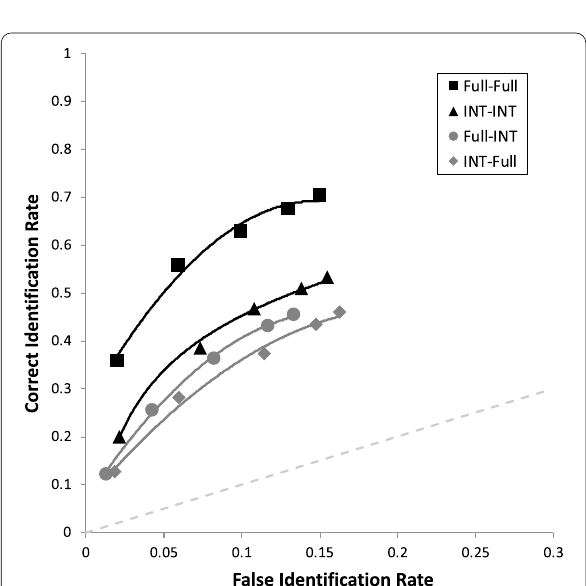
Fig. 6 ROC curve for each match versus mismatch condition. Full full face; INT internal face only. For example, Full-INT = = represents a full face presented at encoding, followed later by internal face, collapsed over showups and lineups